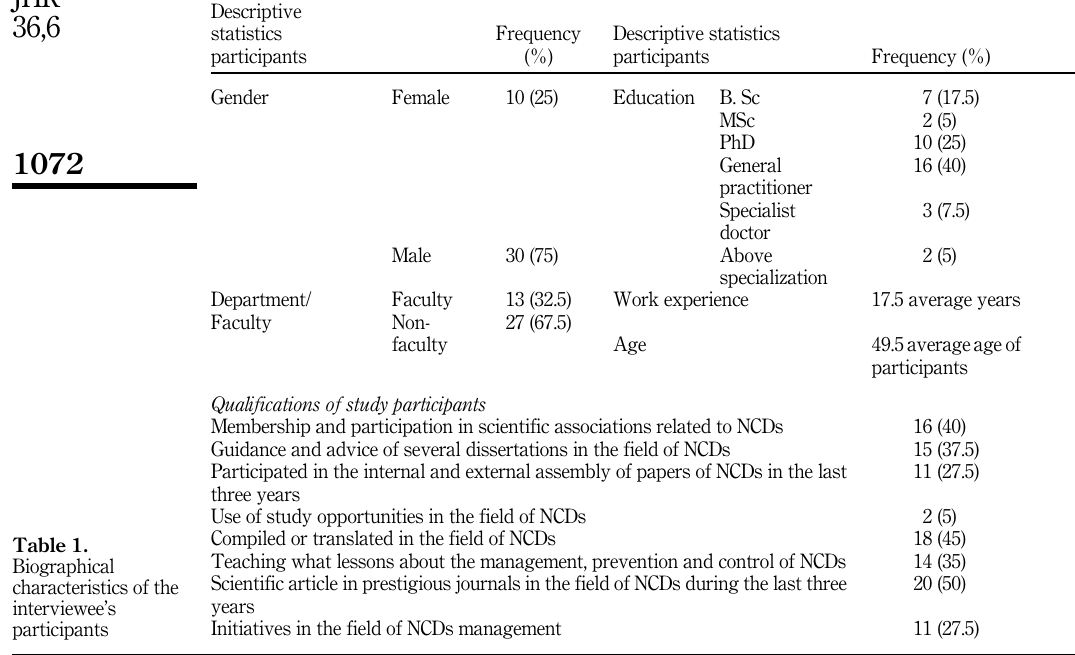
characteristics of the interviewee ’ s